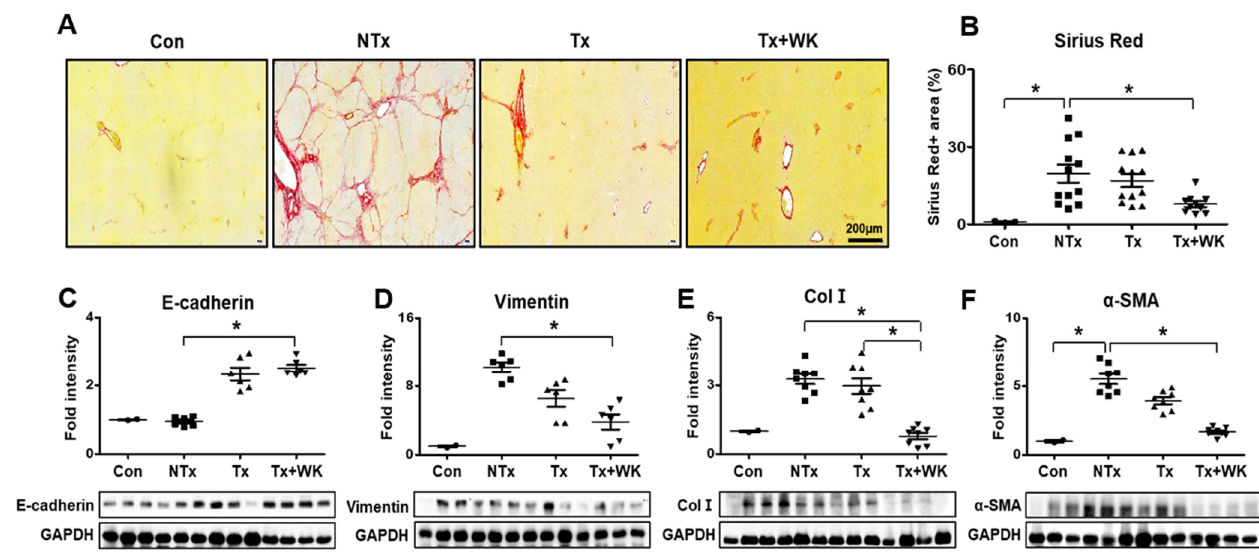
Figure 4. PD-MSCs combined with WKYMVm attenuated hepatic fibrosis in the BDL rat liver. ( A ) Collagen deposition in BDL rat liver shown by Sirius Red staining. Scale bar = 200 μ m. ( B ) Quantification of the Sirius Red-positive area in BDL rat livers through Sirius red staining. Protein expression of E-cadherin ( C ), vimentin ( D ), Col I ( E ), and α -SMA ( F ) in BDL rat livers shown by Western blots. Protein expression was normalized to GAPDH expression through Western blot bands. n = 3 rats per group, mean ± SD, *, p < 0.05 by one-way ANOVA. Con, control; NTx, nontransplantation group; Tx, PD-MSC transplantation group; Tx+WK, PD-MSCs with WKYMVm combined transplantation group; wk, week.